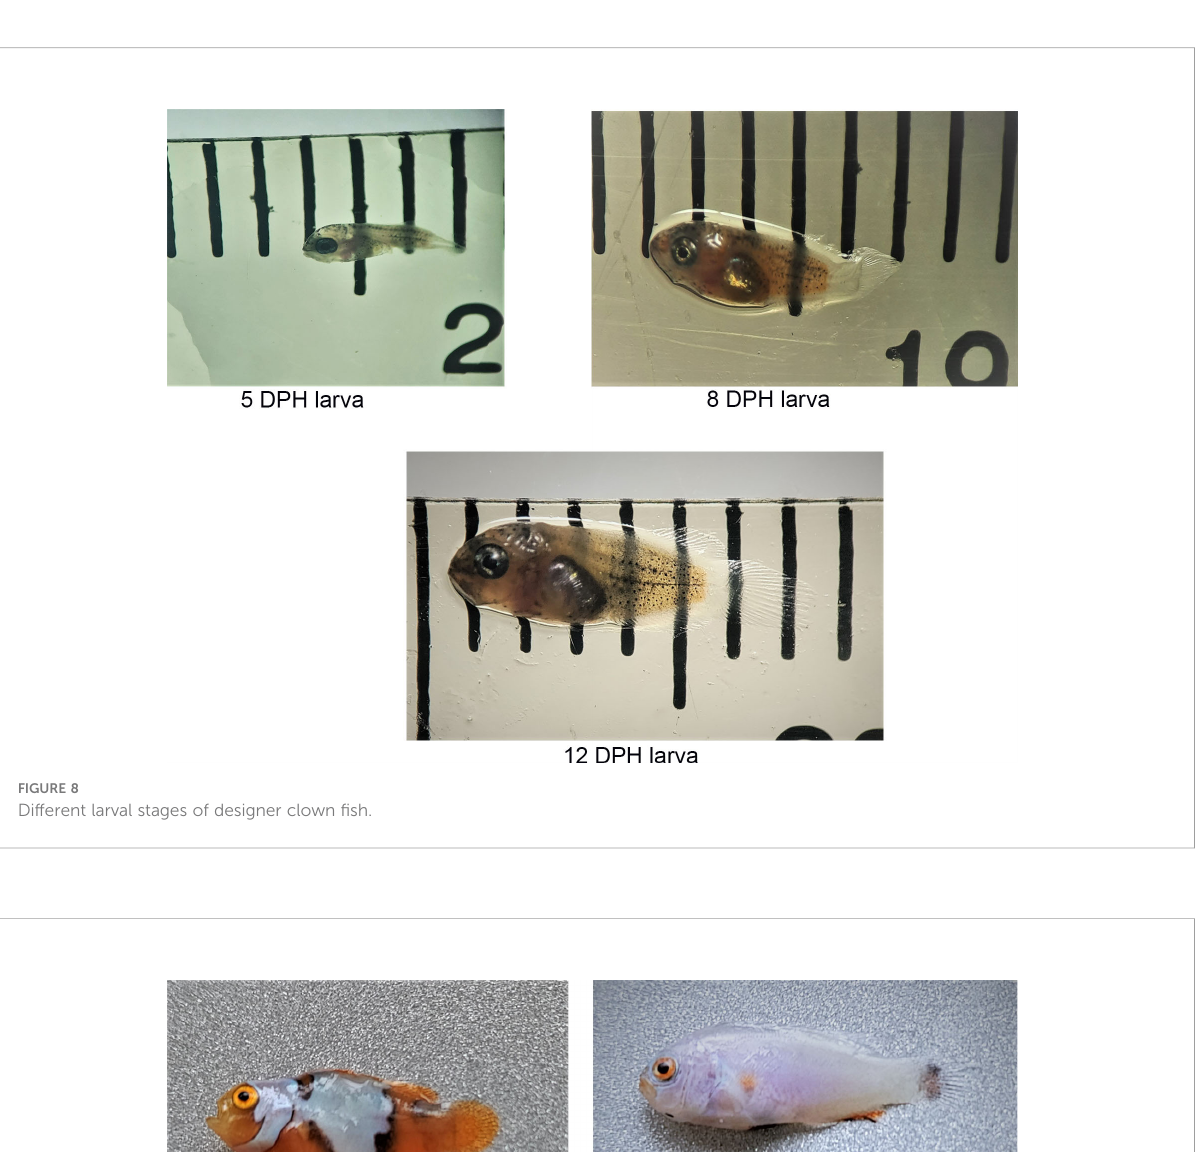
FIGURE 8 Different larval stages of designer clown fi sh.